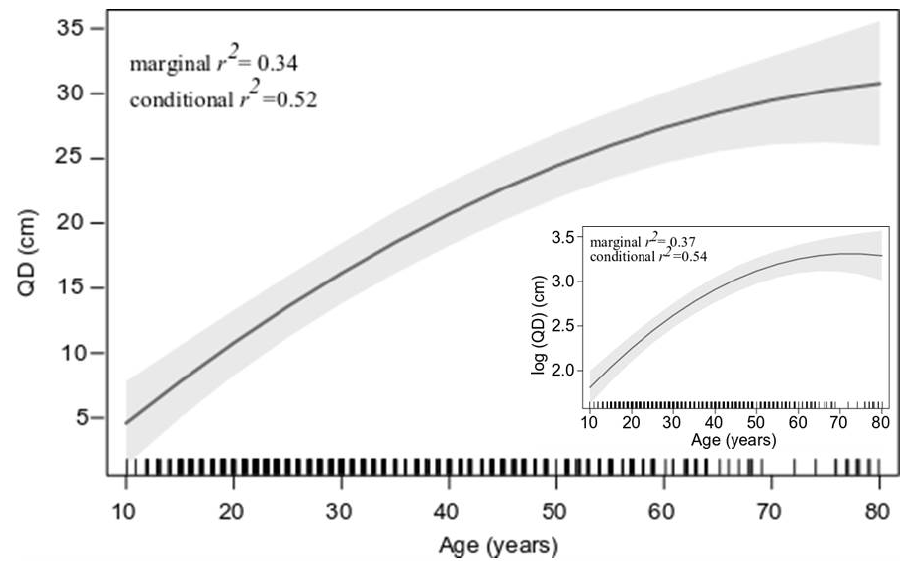
Figure 2. Relationship between QD (quadratic diameter) and tree age. The inset panel shows the relationship between QD in a logarithmic scale and age. r 2 is the coefficient of